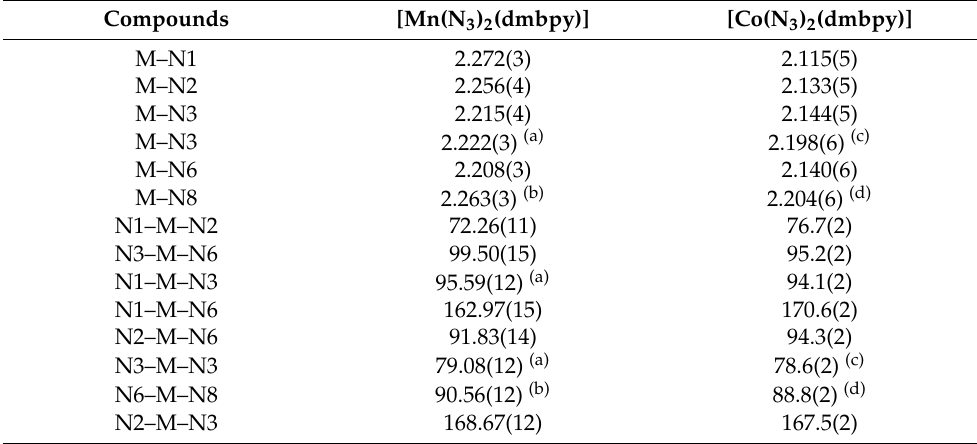
Table 1. Selected bond lengths (in Å) and angles (deg.) for both